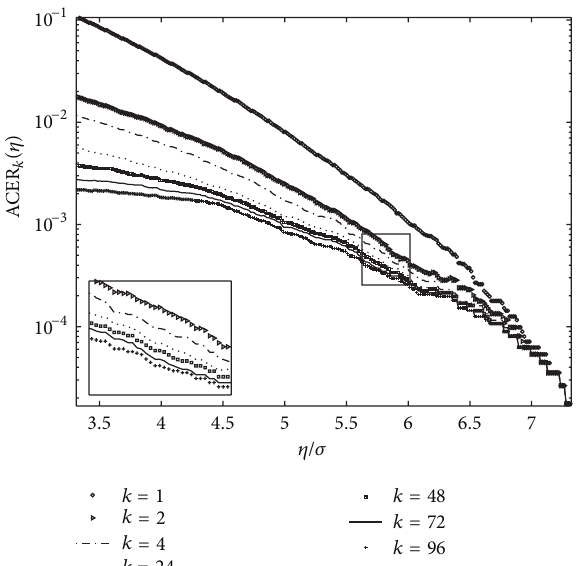
Figure 5: Nordøyan wind speed statistics, 13 years hourly data. Comparison between ACER estimates for different degrees of con- ditioning. 𝜎 = 6.01 m /